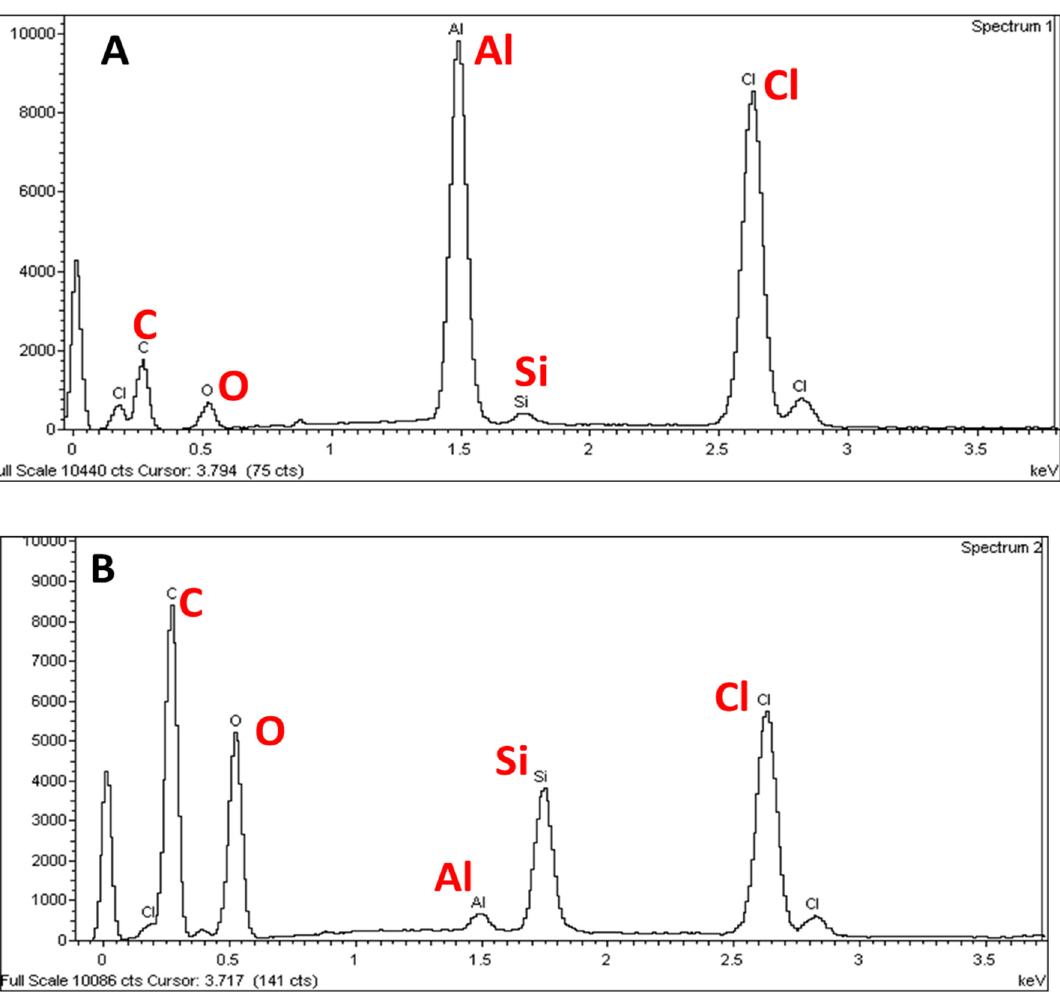
Figure 1. EDX spectra of the S1 ( A ) and S2 ( B ) electrode surfaces. The S1 electrode was fabricated from an inner surface of the wrapper (silver color) whereas the S2 electrode was prepared from an outer surface of the wrapper (gold color).